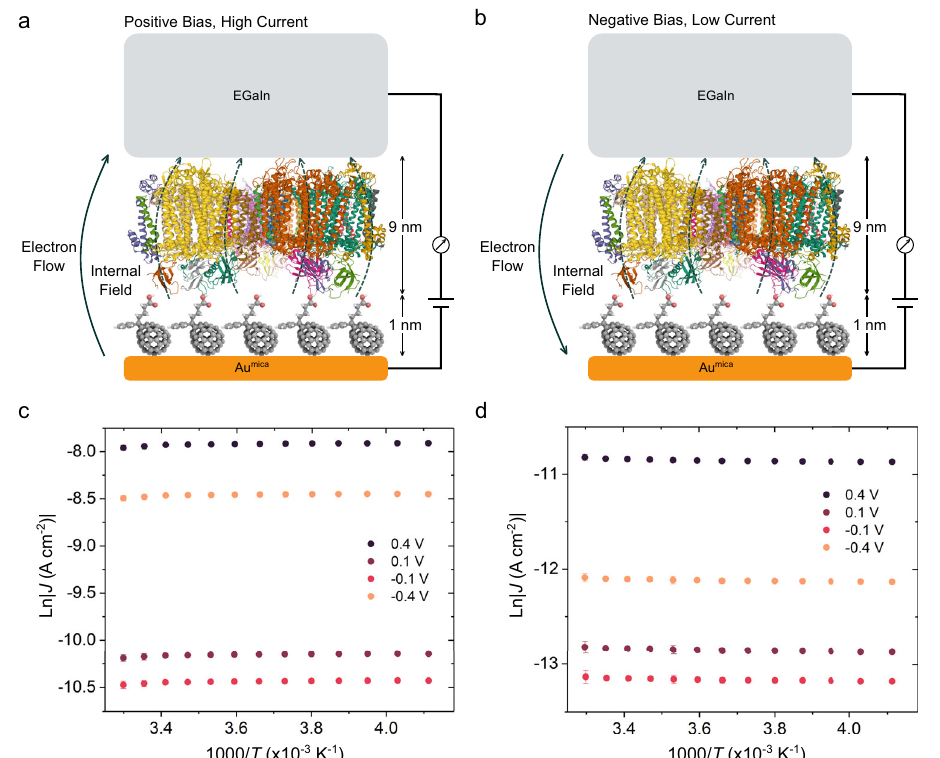
Fig. 3 Direction of the internal electric fi eld (dashed lines) that arises from the PSI dipole moment within Au mica /PCBA//PSI//EGaIn junctions, which are shown with EGaIn biased both positively and negatively with respect to the normal wiring of EGaIn junctions. The direction of this fi eld goes from negative to positive in the PSI complex. a When a positive bias is applied, the direction of the internal electric fi led is the same as the applied bias. b When a negative bias is applied, the electric fi eld from the applied bias opposes the internal electric fi eld of the PSI complexes. Thus, this mechanism predicts the recti fi cation from the junctions. c Plots of ln| J | as a function of temperature in Au mica /PCBA//EGaIn junctions ranging from 243 K to 303 K measured at an interval of 5 K. d Plots of ln| J | as a function of temperature in Au mica /PCBA//PSI//EGaIn junctions ranging from 243 K to 303 K measured at an interval of 5 K. Drawings of molecules do not correspond to their actual